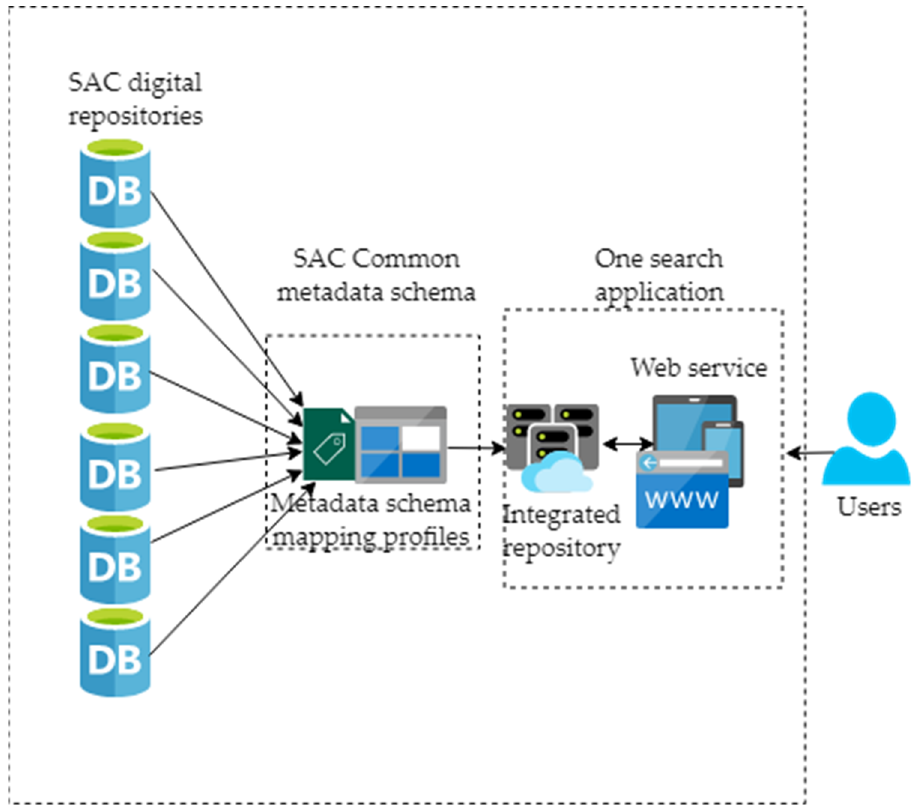
Figure 2. Data integration among SAC ’ s digital repositories based on metadata schema mapping.